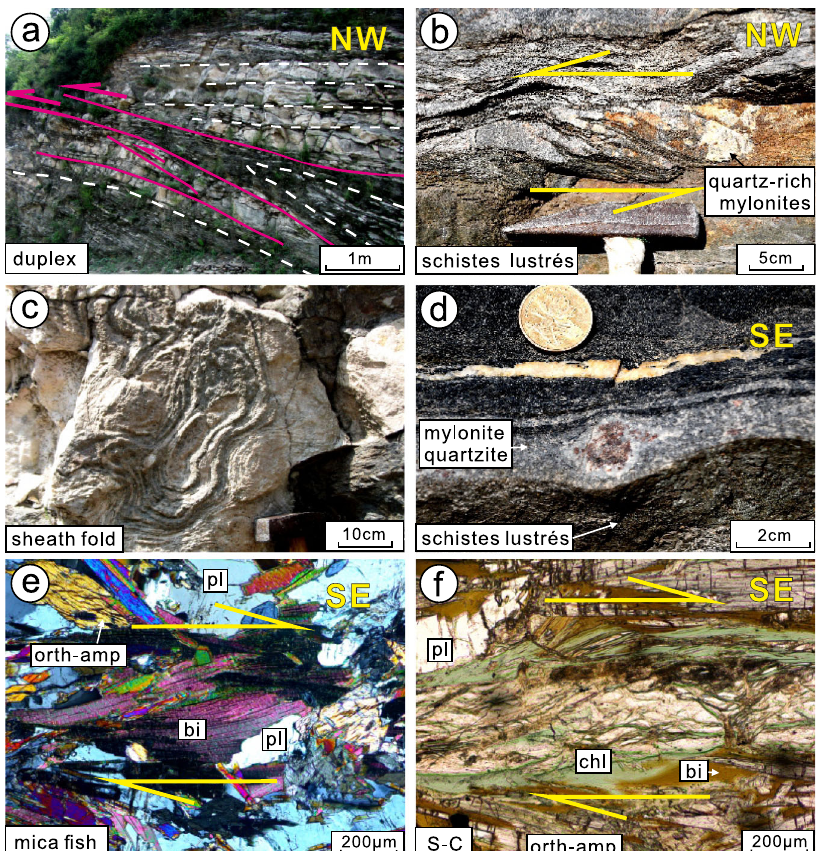
Fig. 3 Representative deformation features of the Zanhuang fold nappe/thrust belt. a Roof and fl oor thrusts in a duplex structure, with incipient horses bounded by linked thrusts, and an incipient nappe climbing over the fl oor ramp; b small-scale nappes in recrystallized quartz-rich mylonites along the upper contact of the schistes lustrés , mimicking the larger-scale geometry of the belt; c sheath fold in marble, looking along hinge to the NW; d contact of the schistes lustrés (bottom of photo) marked by a recrystallized quartz-rich mylonite with asymmetric σ -shaped garnet porphyroblast (top to the SE sense of shear), above which is the tholeiite of the Buddha nappe; e photomicrograph of the schistes lustrés . showing asymmetric mica fi sh, top to the SE sense of shear; f photomicrograph of schistes lustrés , with S-C fabric de fi ned by micas, showing top to SE sense of shear. bi biotite, chl chlorite, orth-amph orthoamphibole, pl